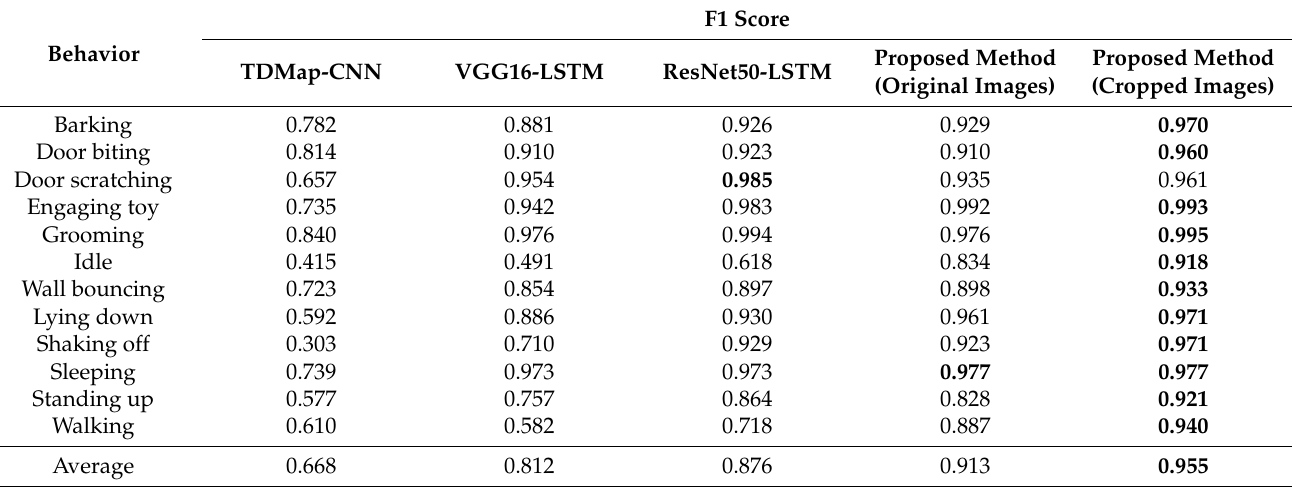
Table 7. Comparison of dog behavior recognition performance using F1 score.